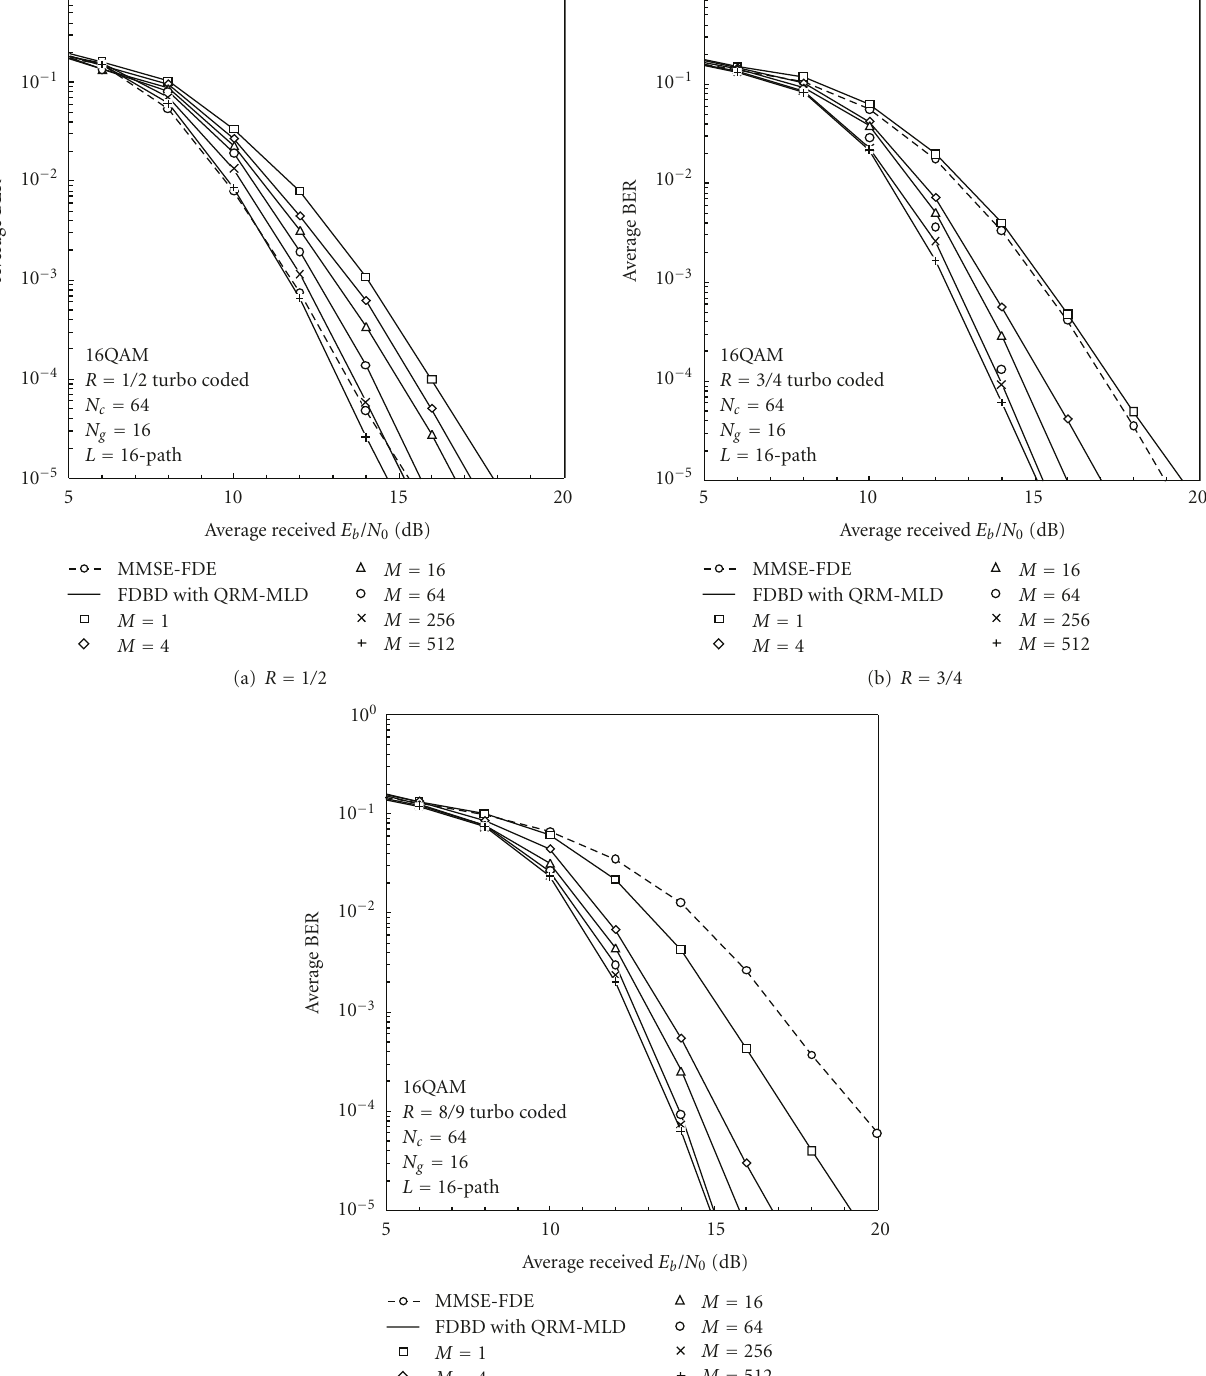
to about 24%, 7.4%, and 2.3% of that in CP-SC for QPSK, 16QAM, and 64QAM, respectively, when N c = 64 and L = 16 (uncoded case). We also showed that FDBD with QRM-MLD provides better BER performance than FDISIC